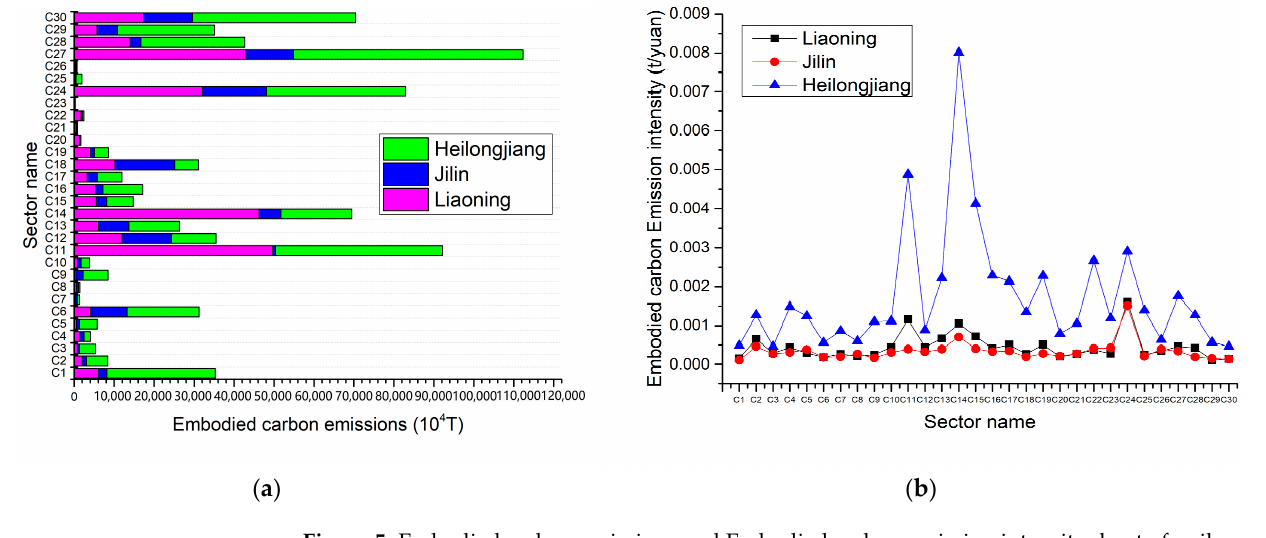
Figure 5. Embodied carbon emissions and Embodied carbon emission intensity due to fossil energy consumption of various industrial sectors in Hei-Ji-Liao. ( a ) Embodied carbon emissions of various industrial sectors in Hei-Ji-Liao. ( b ) Embodied carbon emission intensity of various industrial sectors in Hei-Ji-Liao.